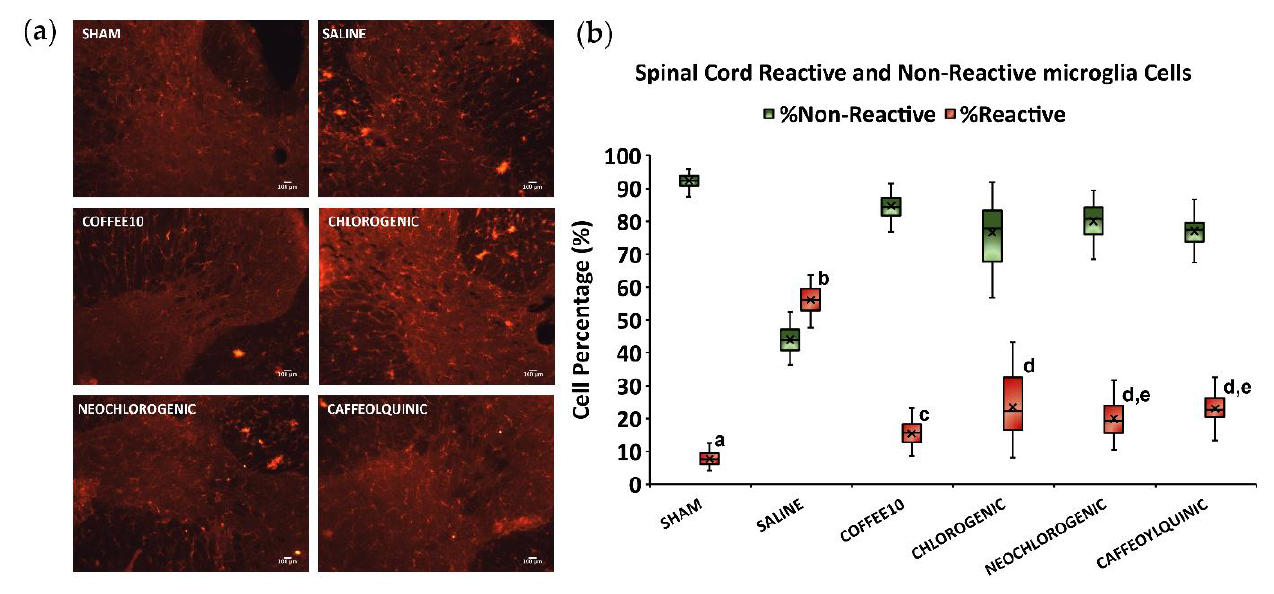
Figure 4. Spinal cord microglia reactivity after polyphenolic treatments fourteen days post-injury: ( a ) Representative IBA1 images of dorsal horn for each group. Scale bars = 100 μm ; ( b ) Percentage of reactive and non-reactive microglia cells. Data are illustrated as median ± IQR, and the x indicate the mean. a – e: not sharing a letter means significant differences, p < 0.05.